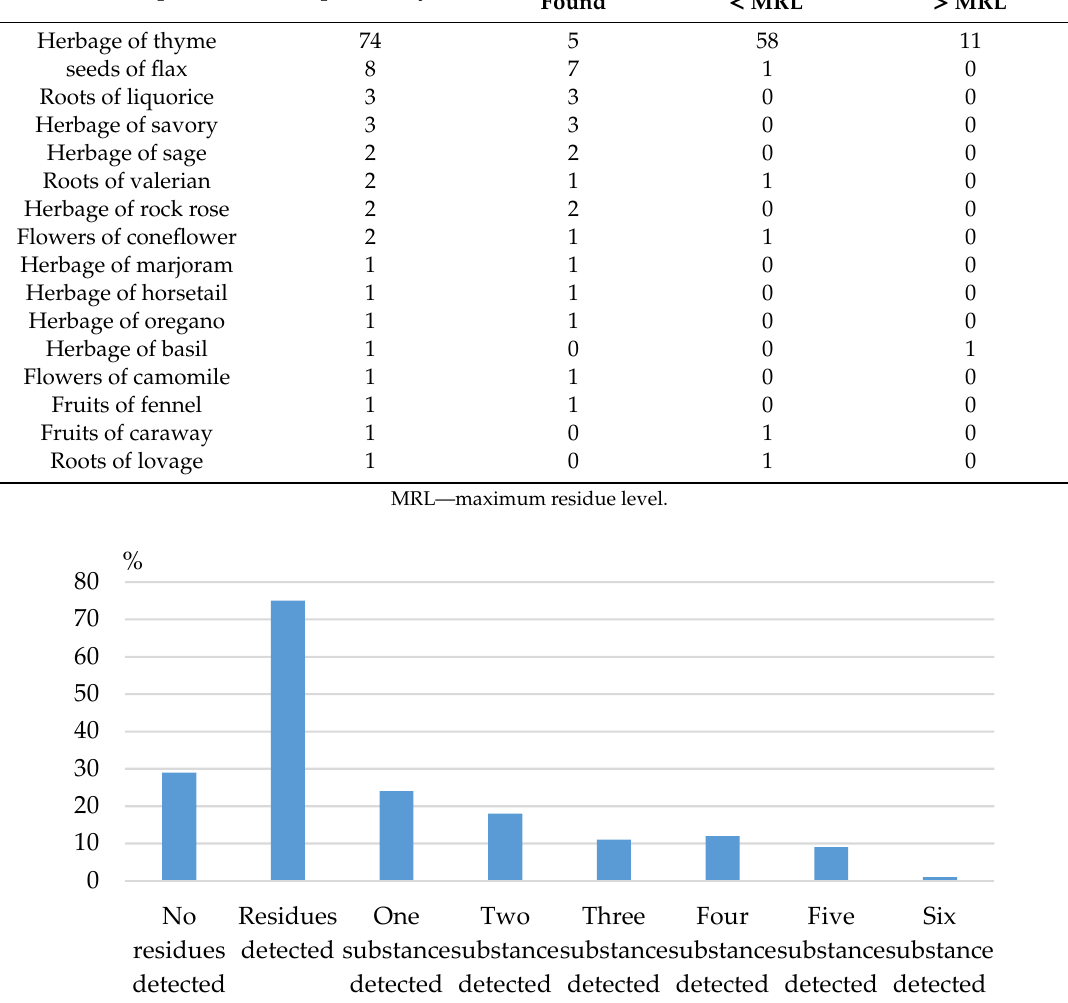
Figure 1. Distribution of samples with detected pesticide residues.